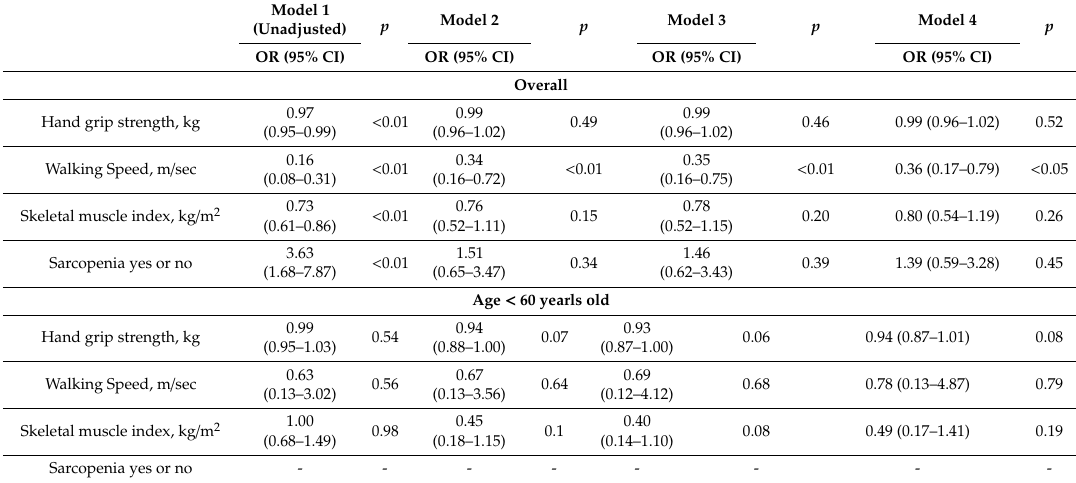
Table 3. Multivariate-adjusted odds ratio for mild cognitive impairment (MCI) in patients with type 2 diabetes mellitus odds ratio for